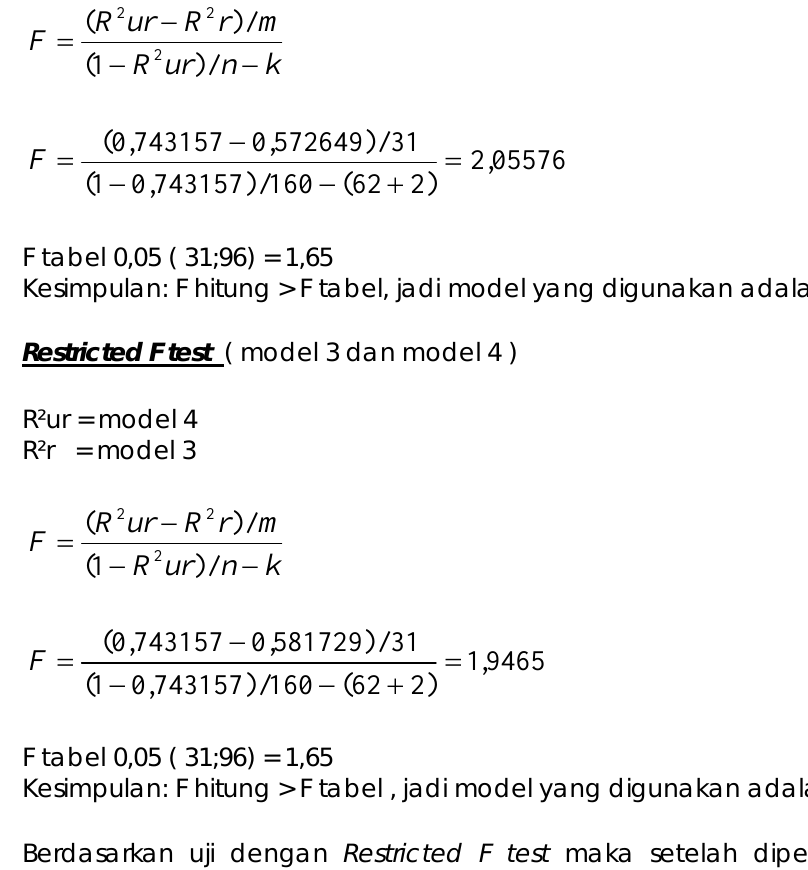
tabel. Pada model 2 intercept bervariasi antar 32 perusahaan namun